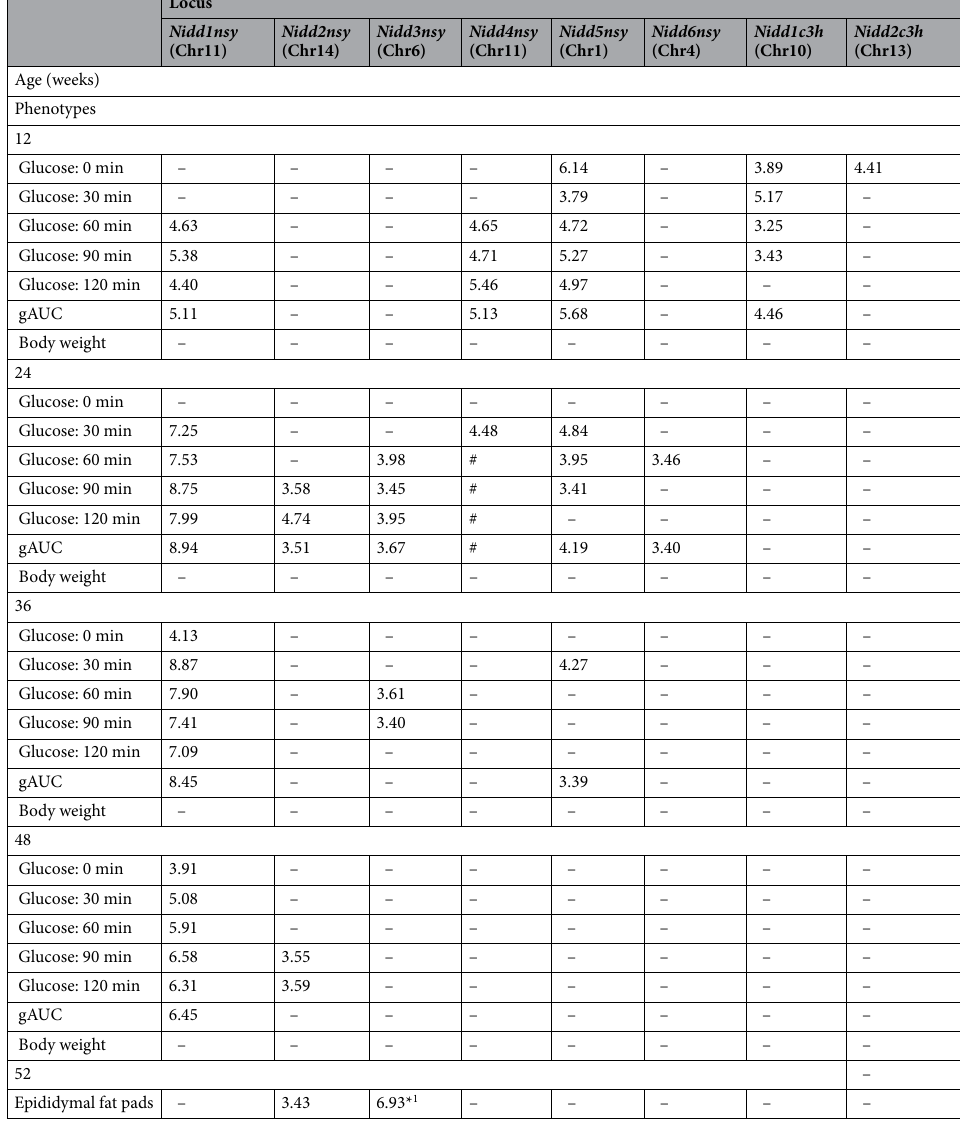
Table 1. Maximum LOD scores for diabetes-related phenotypes in the detected QTLs. Maximum LOD scores calculated by R/qtl are shown. Threshold LOD values obtained using the multiple imputation approach at α = 0.05 are between 3.18 and 3.41, and at α = 0.01 are between 3.76 and 4.22. AUC area under the curve. – Data not significant; # omitted because there was no obvious peak and heavily influenced by Nidd1nsy . * 1 This locus overlaps with Fn1n 17